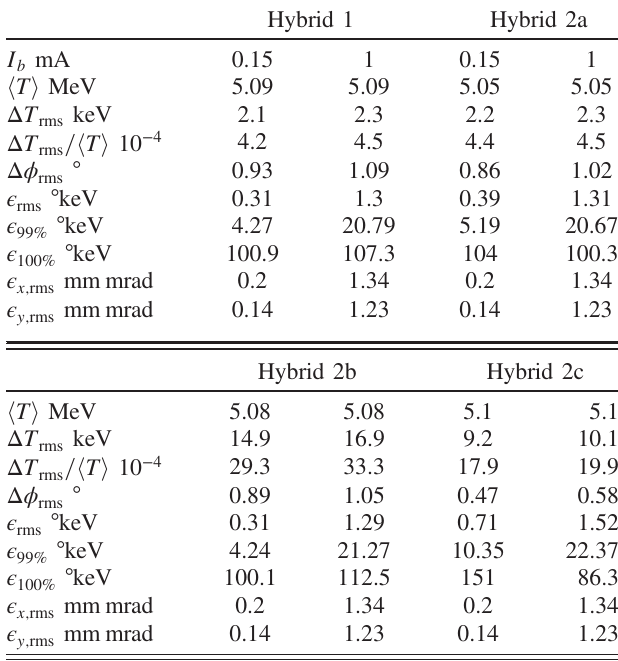
TABLE V. Comparison of longitudinal bunch data of the hybrid MAMBO versions under investigation as found 0.1 m behind the end of the last rf section. Further the transverse rms emittances are given to judge the phase space evolution.